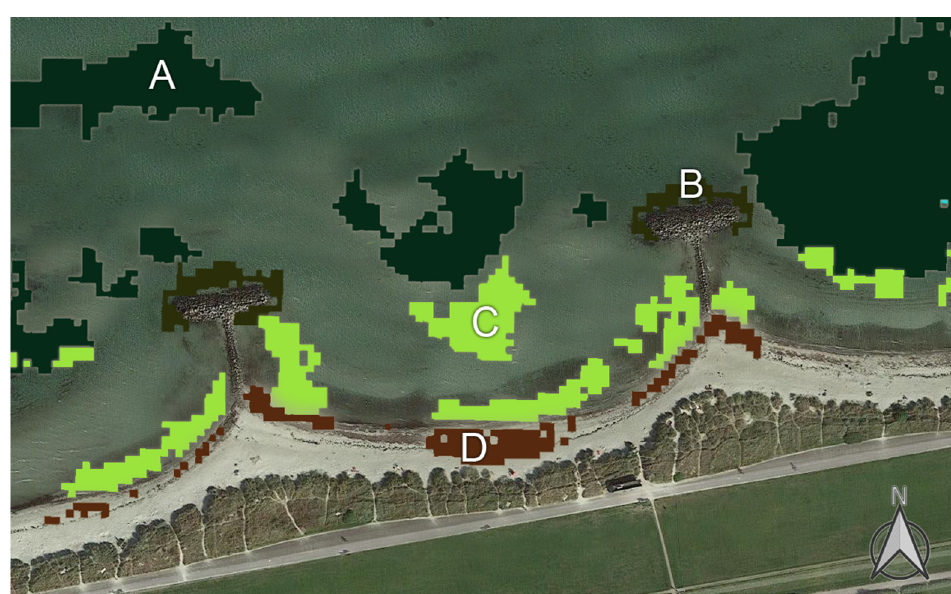
Figure 1. Location of the study area.